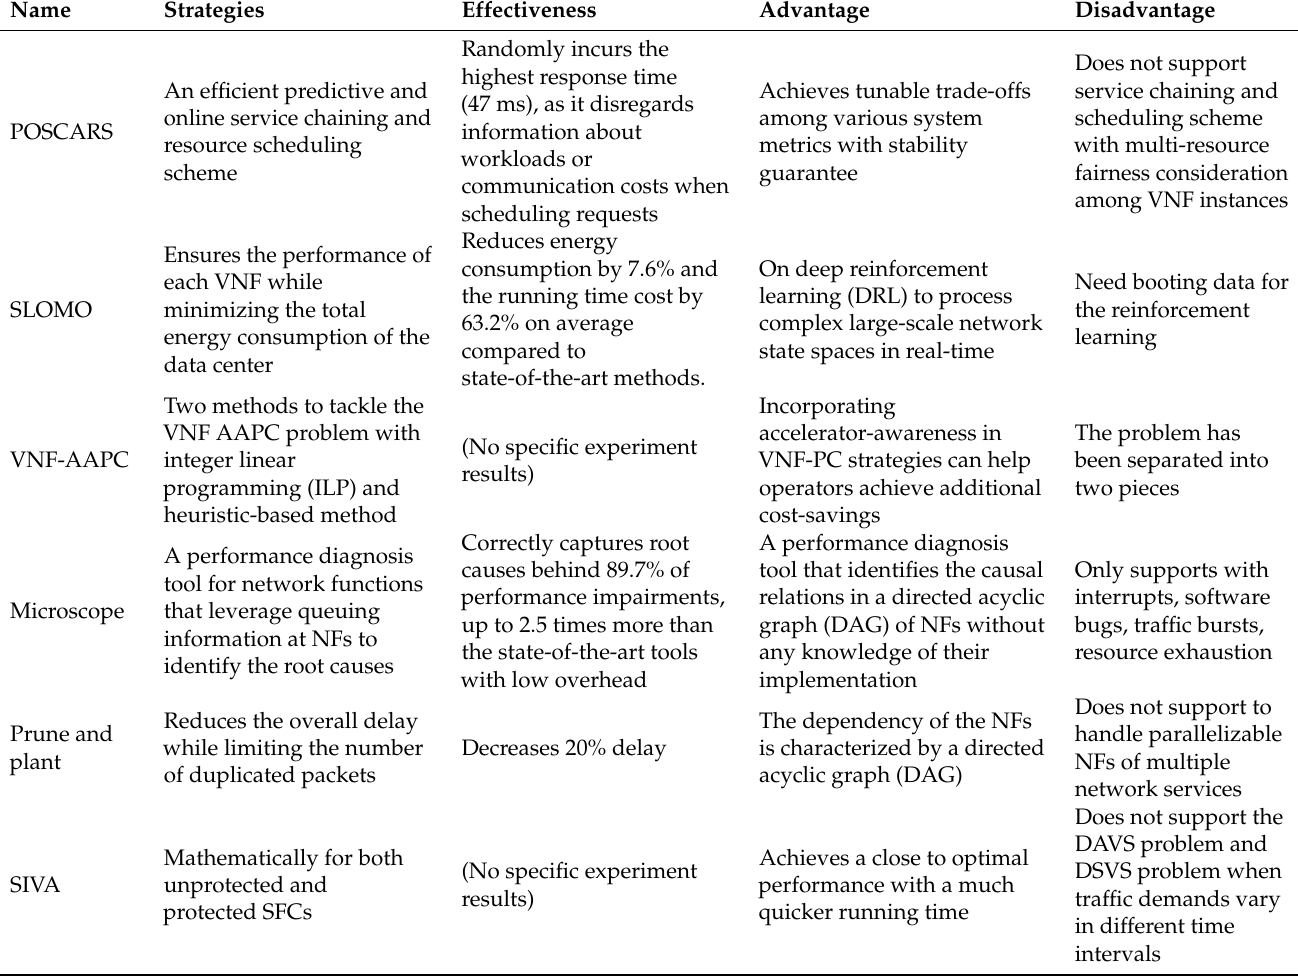
Table 7. The acceleration solutions in